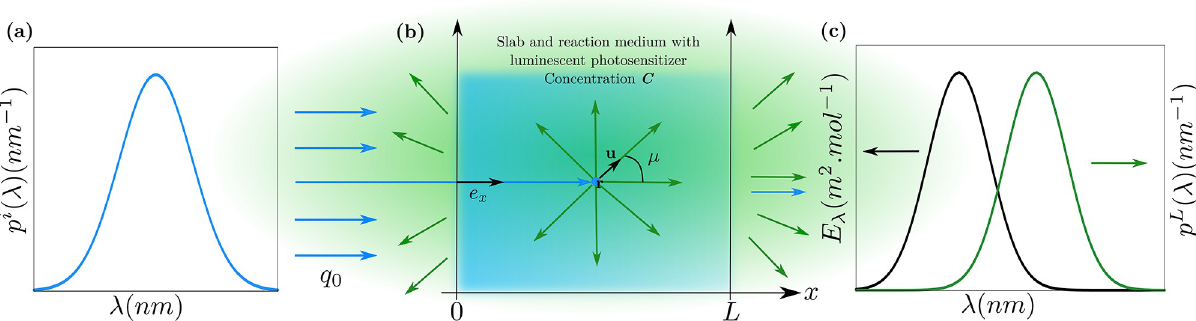
Fig 1. Radiative configuration. (a) Incident-normal collimated radiation at x = 0 with spectrum p i ( λ ) and surface flux density q 0 . (b) Slab of thickness L containing a luminescent photosensitizer solution at concentration C . The phase space ( r , u ), with u the propagation direction, can be reduced to ( x , μ ) in such a one-dimensional slab. In this case, the isotropic distribution p ð u Þ ¼ 1 with μ = cos θ [35]. (c) Examples of molar extinction cross-section E λ and luminescence spectra p L ( λ ) of the